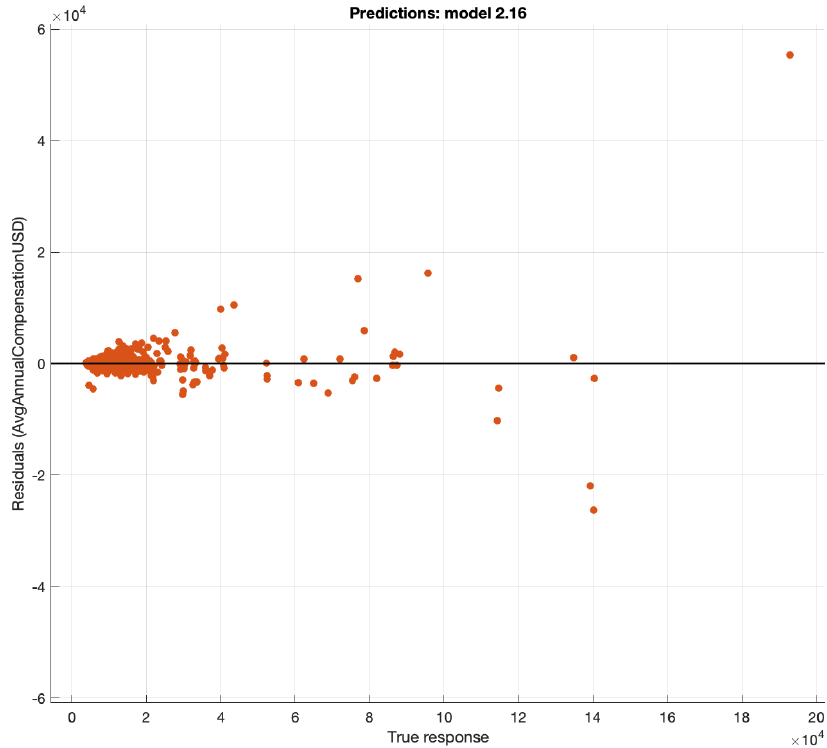
Figure 4. Residual errors plot for Bayesian ML regression across economic activities.